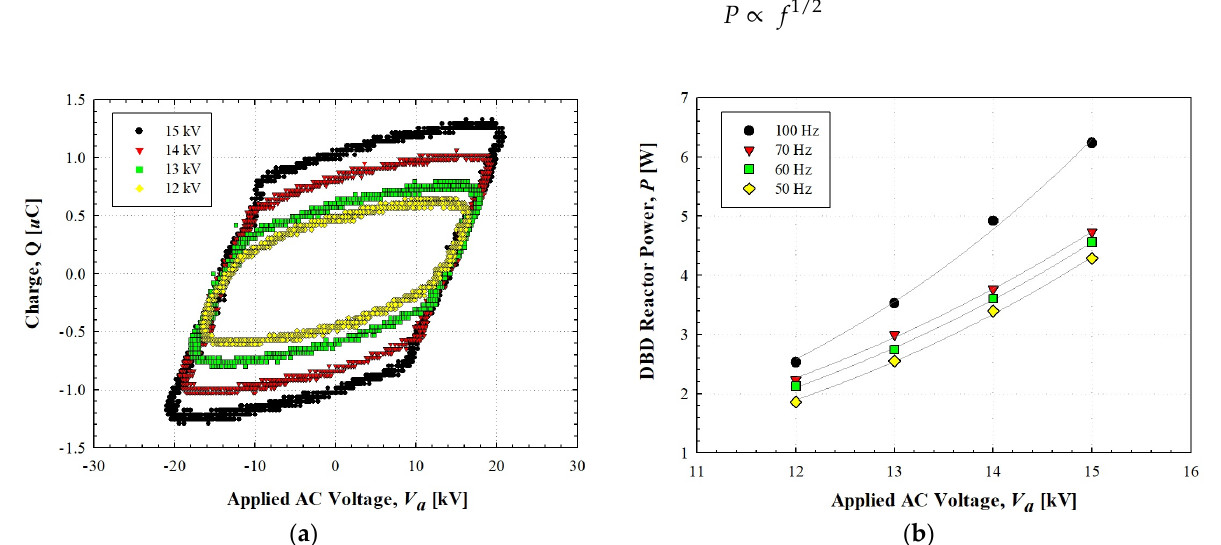
Figure 3. ( a ) Q - V Lissajous curve based on the applied voltage at 100 Hz ( b ) P - 𝑉 (cid:3028) graph by frequency.